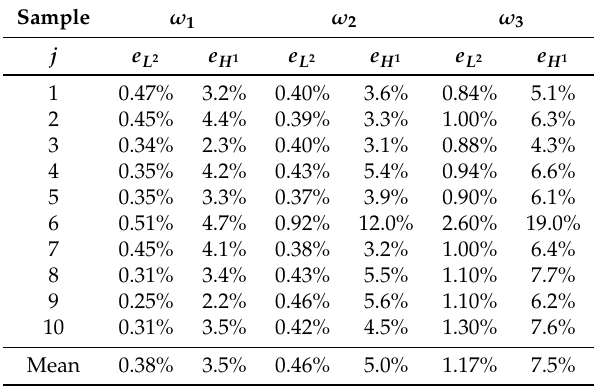
Table 2. Percentage error of multiscale basis functions φ ω i